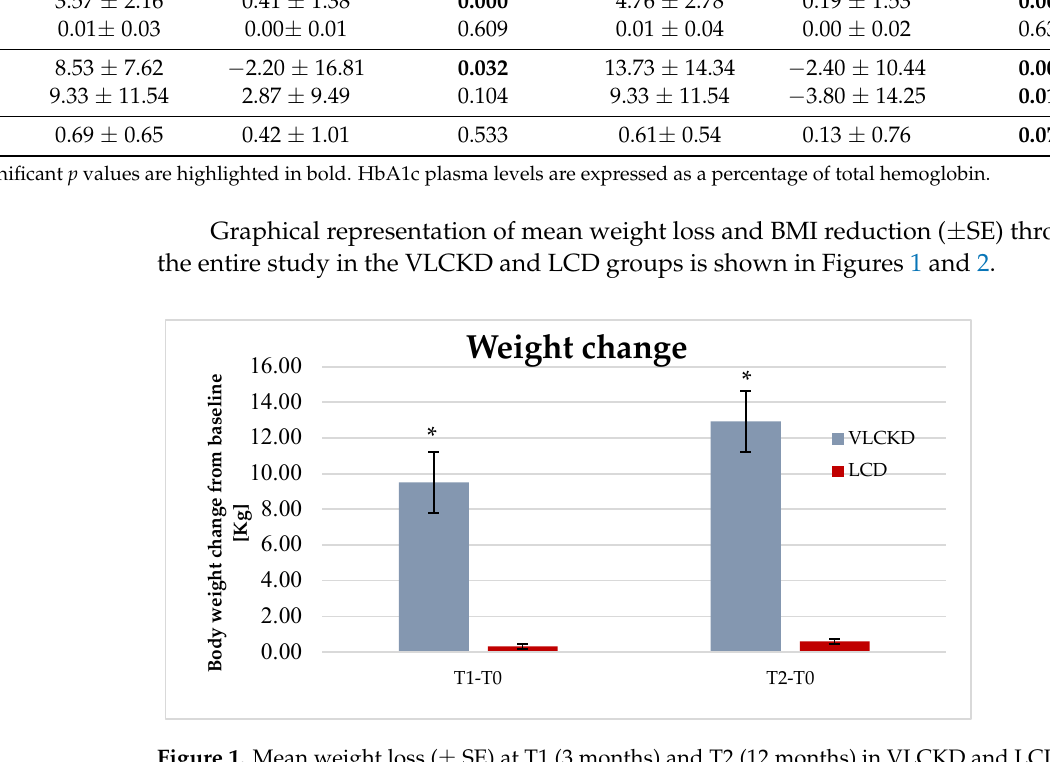
Figure 1. Mean weight loss (± SE) at T1 (3 months) and T2 (12 months) in VLCKD and LCD groups. * p < 0.001.